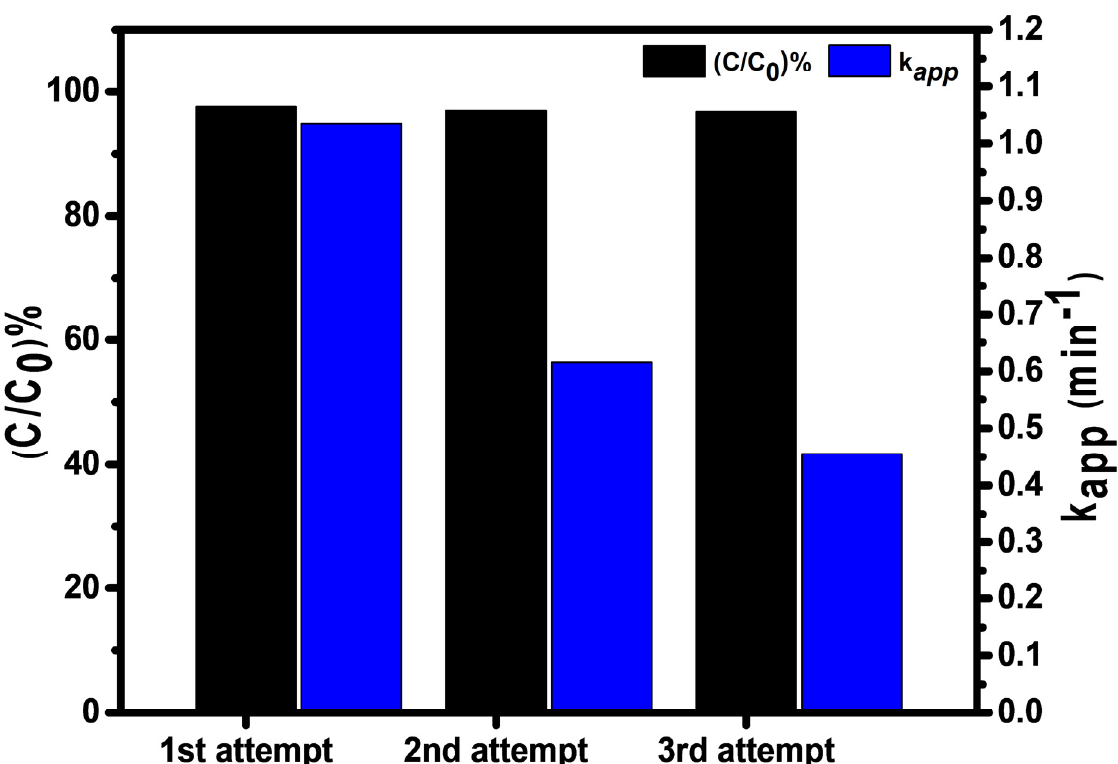
Figure 8. Recyclability of the GL/Co − SnO 2 nanocomposite catalyst.